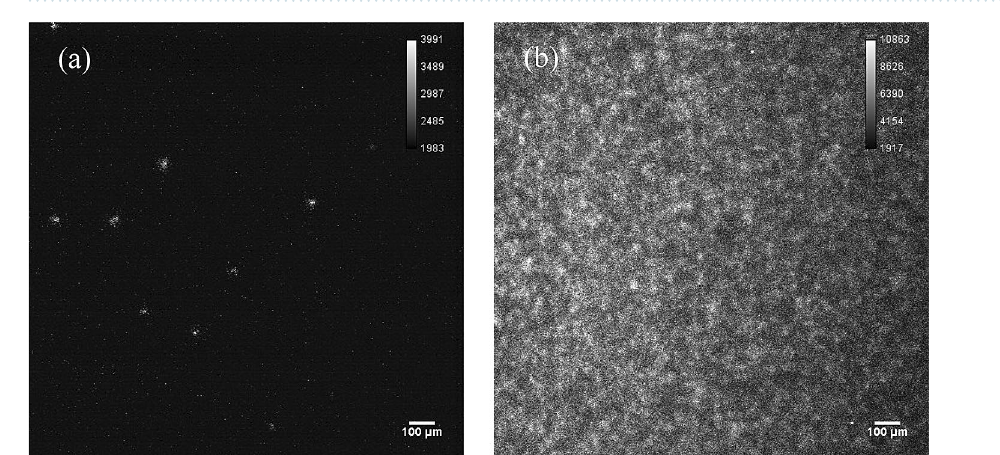
Figure 3. Image of an alpha particle from the active area of the 241 Am alpha source obtained with the zoom range of 5 × using (a) the 50-ms sequence mode and (b) the 10-min acquire mode. The images of using the “Sequence mode” with 50-ms intervals can be found as Supplementary Fig. S1